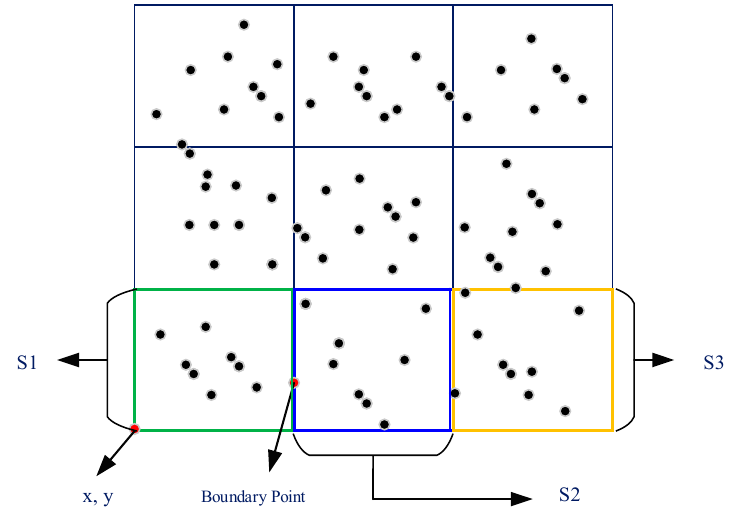
Figure 6. The first phase of data partitioning.